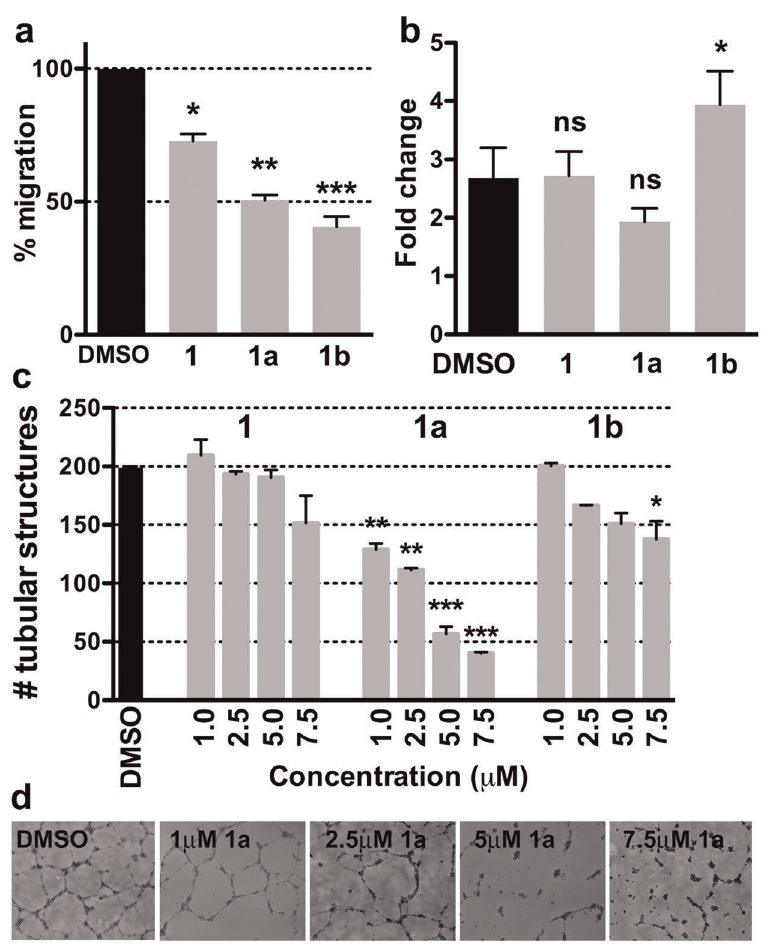
Figure 6. EYA inhibitors attenuate migration and tubulogenesis of HUVECs. ( a ) Percent migration of HUVECs in the presence of 5 m M relative to the vehicle control?. ( b ) Change in cell density after 24 hours in the presence of either vehicle control (0.1% DMSO) or 5 m M of each EYA inhibitor. ( c ) Quantitation of the number of tube-like structures formed by HUVECs in the presence of either the vehicle control (0.1% DMSO) or the indicated concentrations of compounds 1, 1a and 1b. The number of tubes was measured using NeuroJ. Data are mean and standard error of three independent experiments. p-values from a one-way ANOVA are shown; ns is not significant, * p , 0.05, ** p , 0.01, *** p , 0.001. ( d ) Representative images of HUVECs on Matrigel in the presence of the indicated doses of 1a.